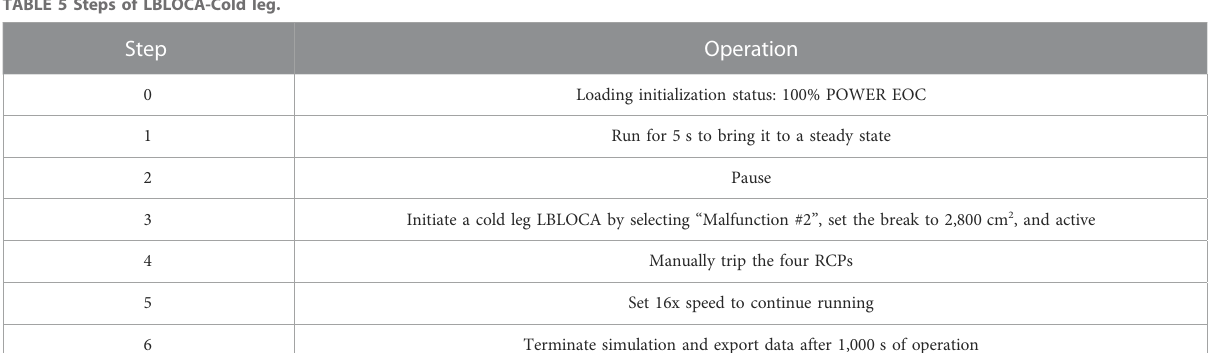
TABLE 5 Steps of LBLOCA-Cold leg.